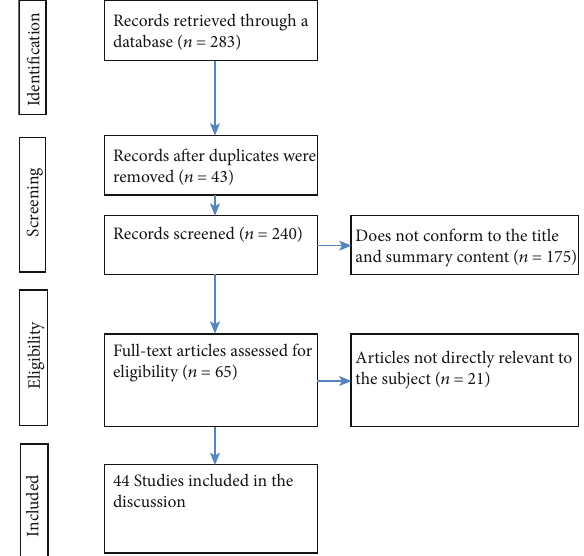
Figure 1: Flow diagram of studies identi fi